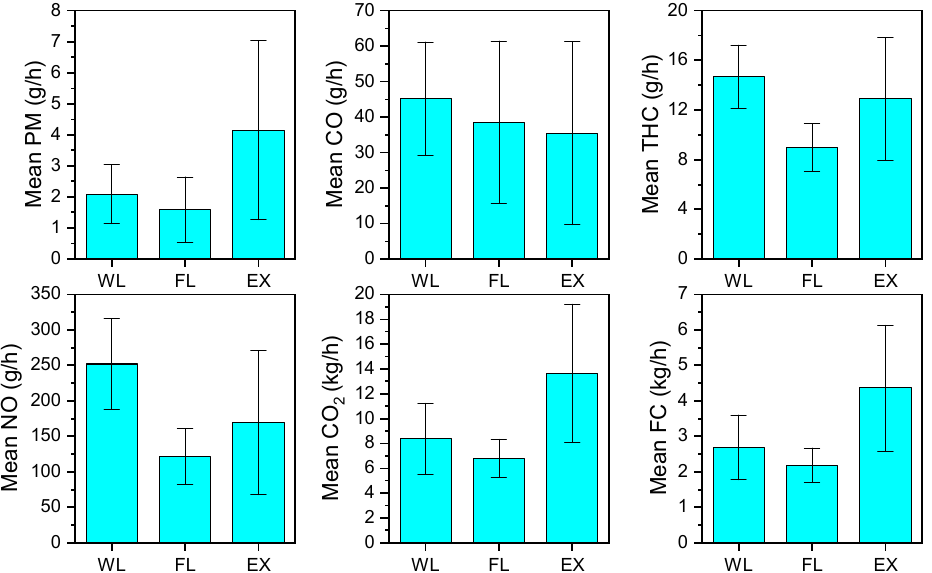
Figure 3. Mean ± SD of real-world time-specific emission factors of PM and gaseous pollutants and fuel consumption rates.